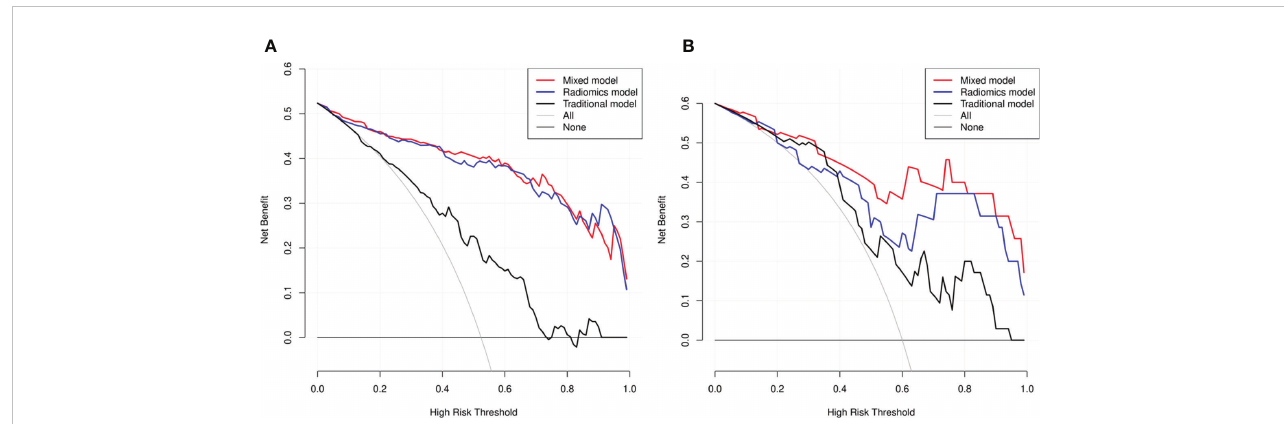
FIGURE 6 Decision curve analysis (DCA) for the three models within the development (A) and testing (B) cohorts. The net bene fi t versus the threshold probability was plotted. The x-axis represented the threshold probability, while the y-axis represented the net bene fi ts. The sensitivity and speci fi city of the model were calculated at each threshold to determine the net bene fi t. The DCAs showed that the net bene fi ts of the mixed model (black line) and the radiomics model (red line) were superior to the bene fi ts of the traditional model (blue line) with the threshold probability range from 0 to